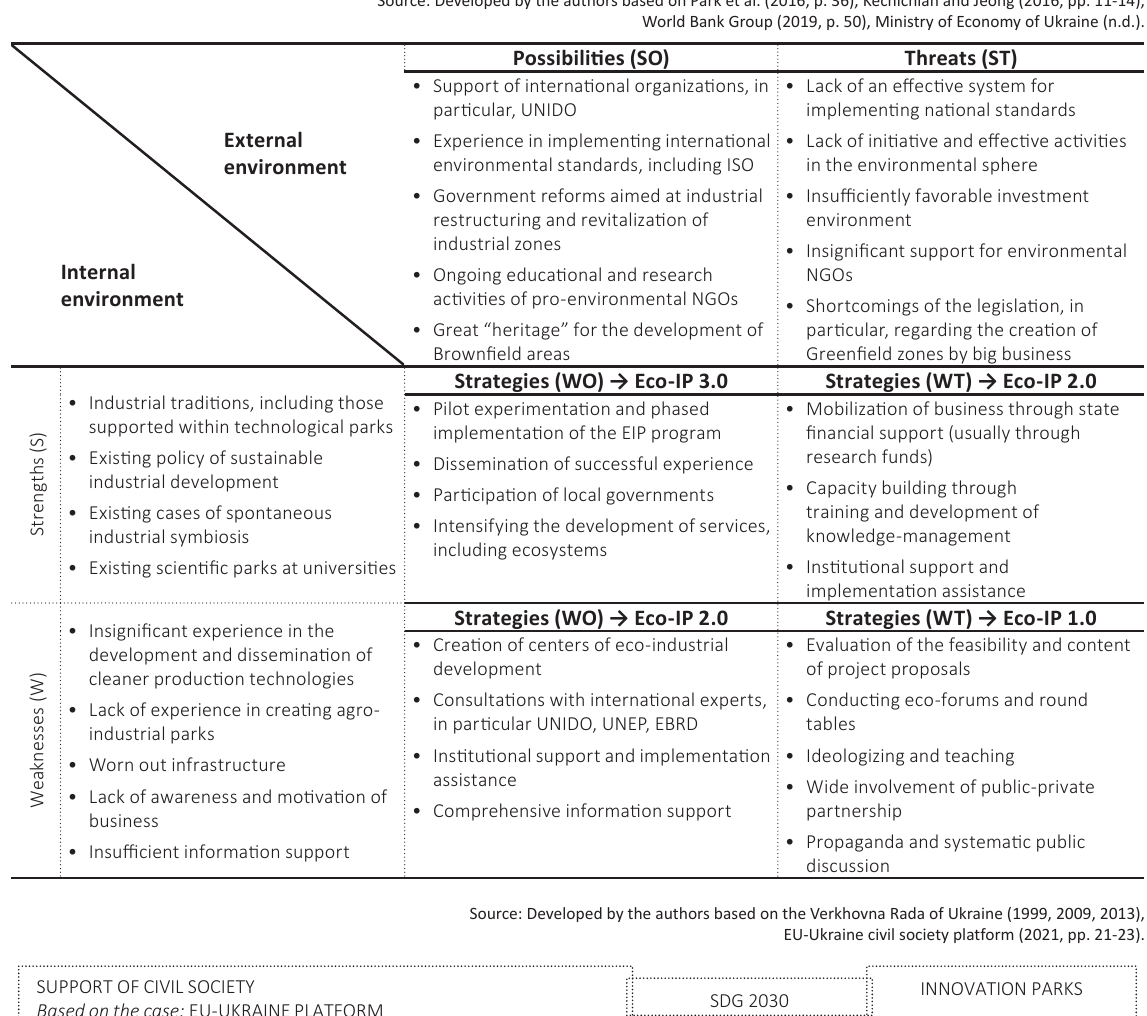
Table 1. SWOT-analysis of EIP development in Ukraine